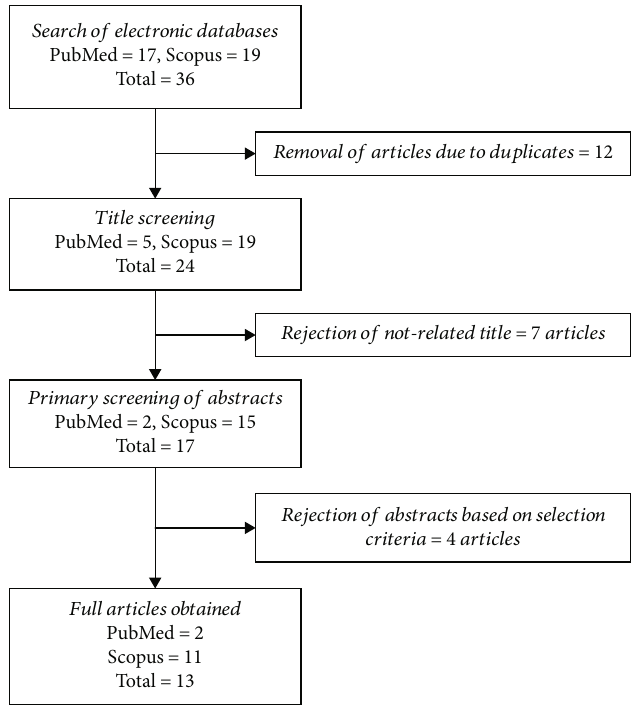
Figure 2: Flow chart of the article selection process from PubMed and Scopus and